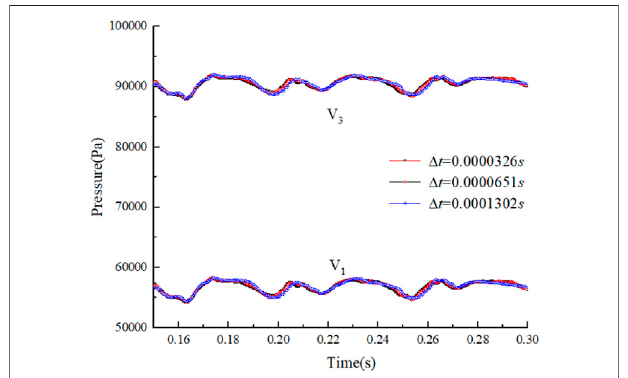
FIGURE 5 | Time-step independence veri fi cation.